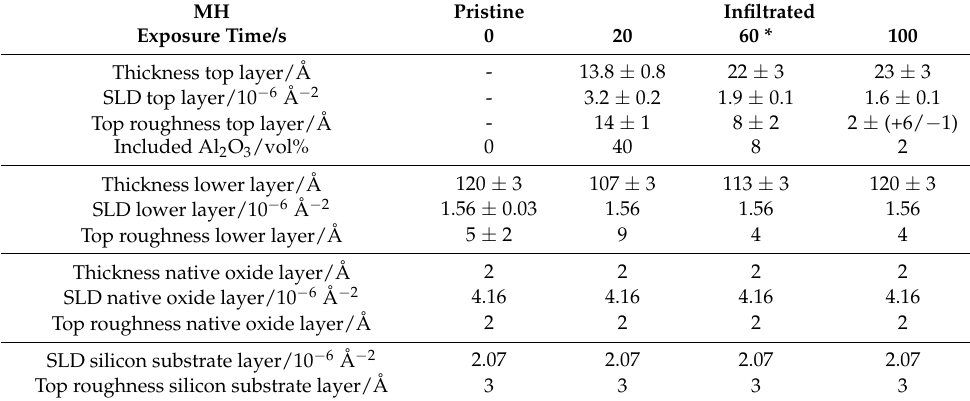
Table 2. Effect of exposure time in semi-static infiltration of trimethyl aluminum/water (TMA/H 2 O) into maltoheptaose